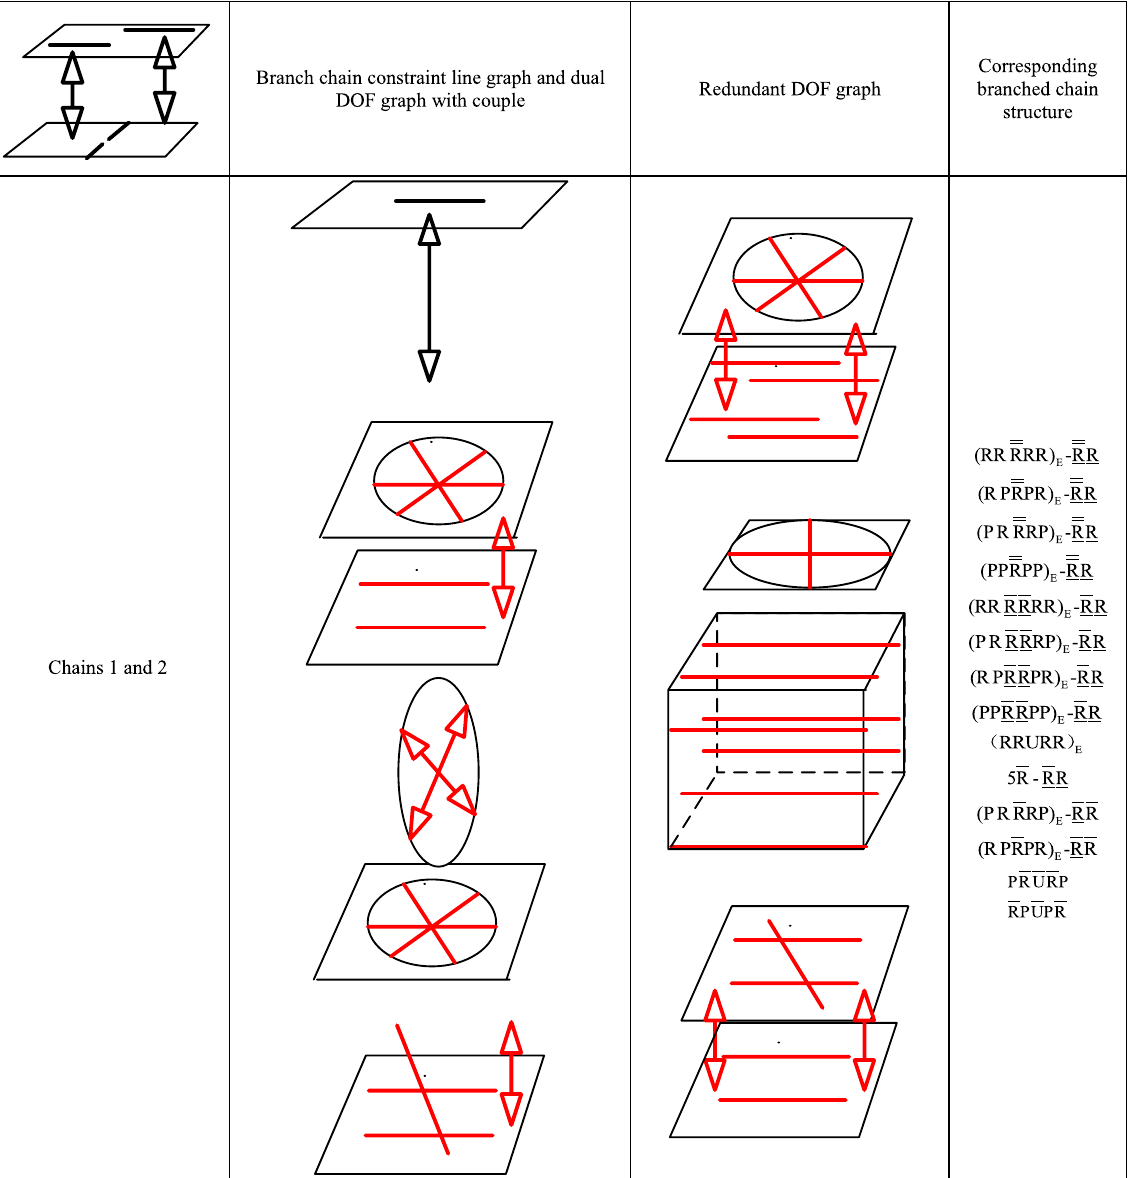
Table 3 Steps (7) ~ (8) synthesis